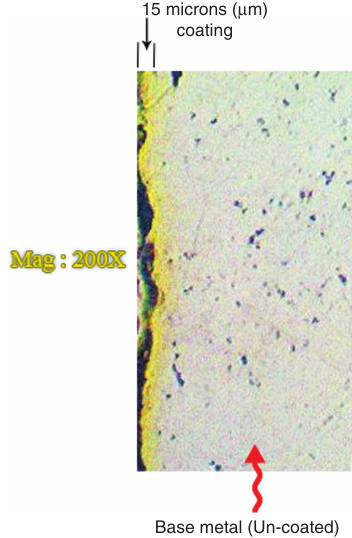
Figure 7 Corrosion test-salt spray test (ASTM B 117-07) of the optimized AISI 304 stainless